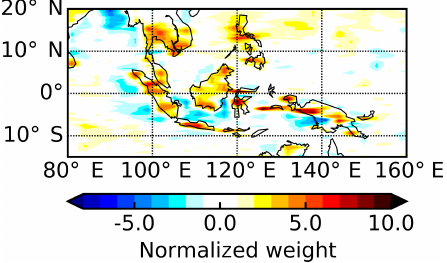
Figure 7. A zoom-in of Fig. 4b showing the second empirical or- thogonal function over the Maritime Continent region bounded by 15 ◦ S–20 ◦ N and 80–160 ◦ E. to be simultaneously varying. Spatially, the first PC of OLR is highly correlated with the diurnal cycle of surface tem- perature at each grid point over land (Fig. 9a), indicating the spatial patterns are also highly coupled. Near the poles the